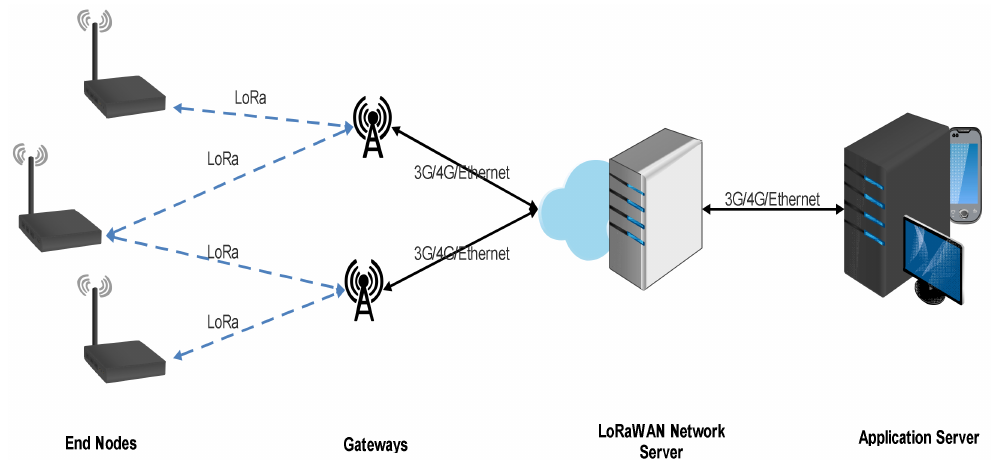
Figure 2. LoRaWAN architecture [4].